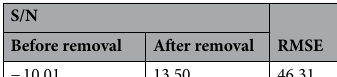
Table 2. Evaluation of denoising of multi-frequency